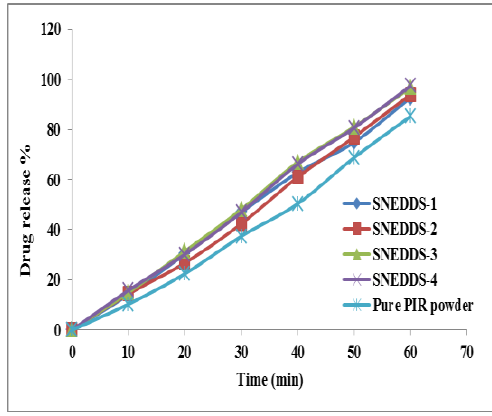
Figure 2. Dissolution profile of PIR SNEDDS (F1, F2, F3 and F4) and pure piroxicam The release profile of pure PIR is slower than prepared SNEDDS formulas and reach 85% at the end of 60 min without dialysis membrane.